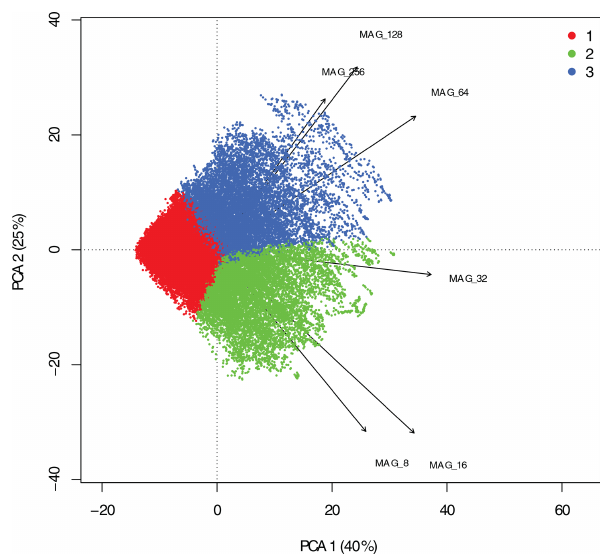
Figure 6. Principal components analysis biplot of C x magnitude of complexity, ≥ 8km, comparing the three-group structure deter- mined using both k -means and PAM clustering.